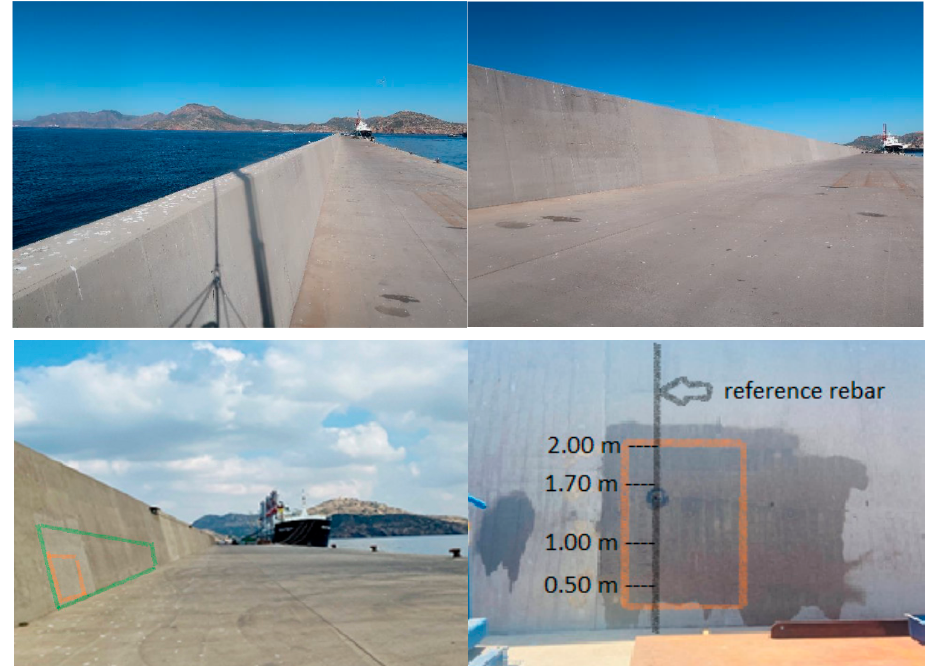
Figure 6. General view of Section 2 and experimental area.